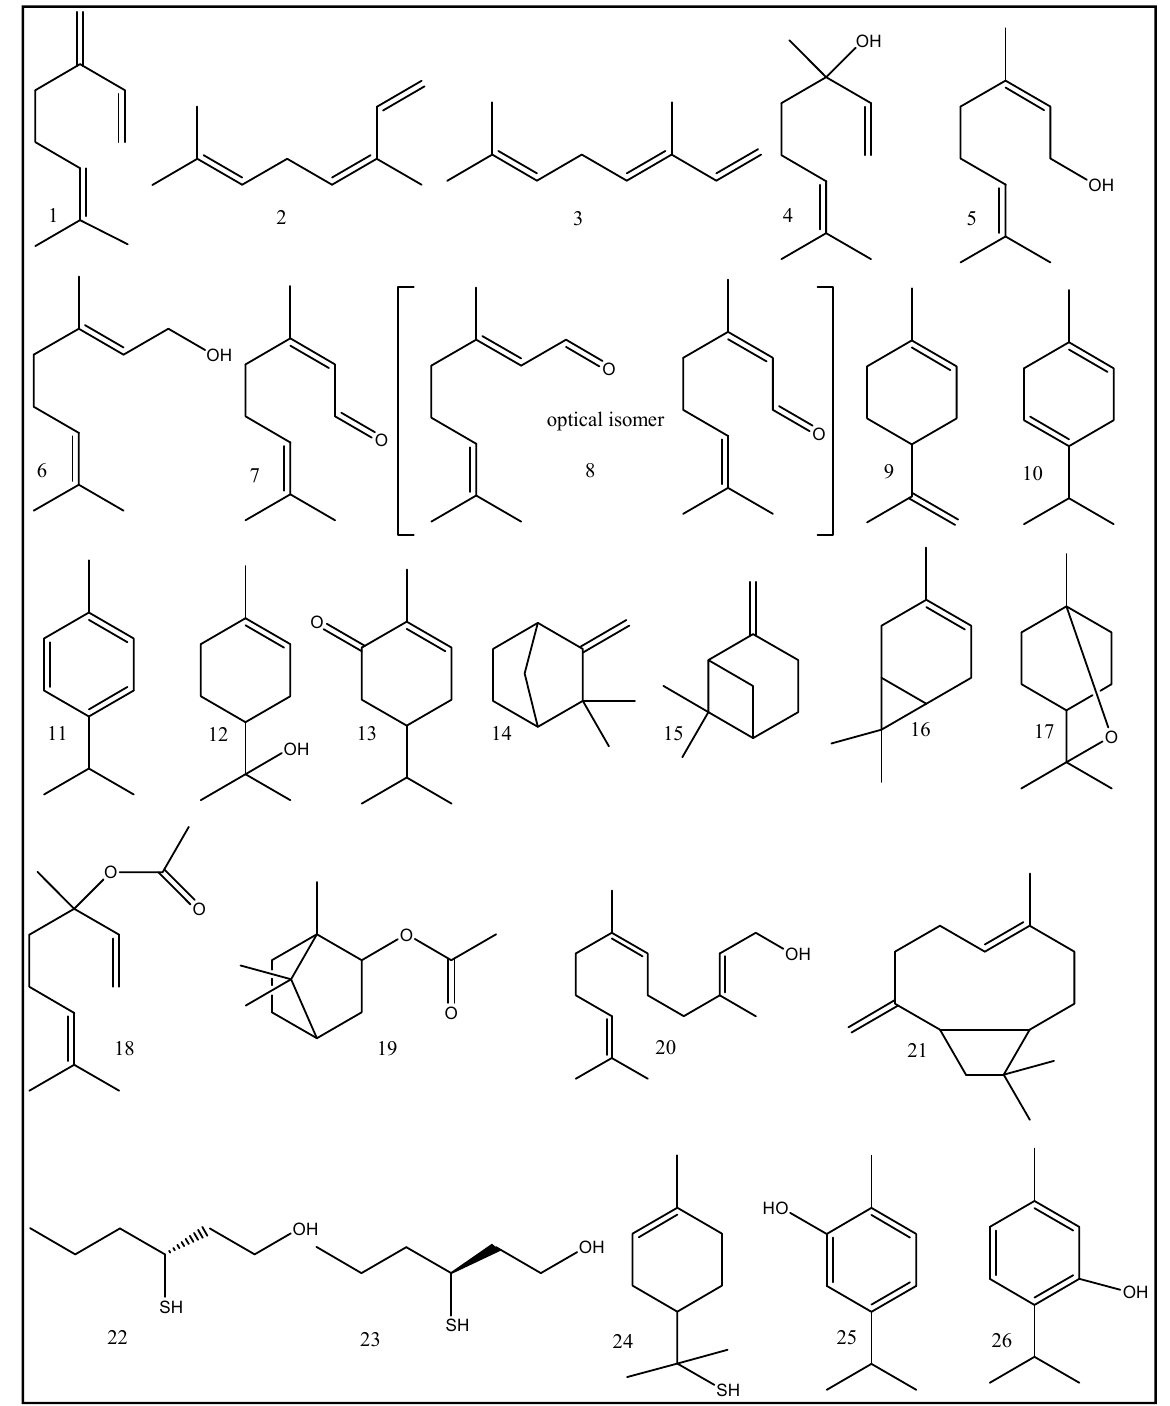
Figure 1. Chemical structure of the main volatile compounds of essential oils. Table 1. Sensory properties of some volatile compounds .